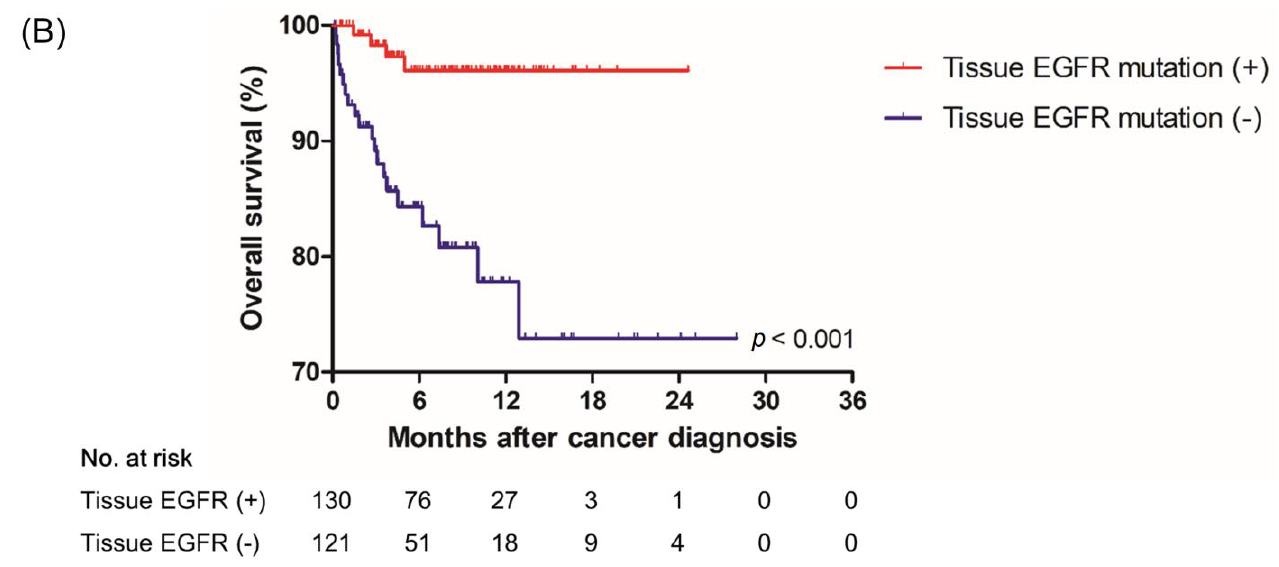
Figure 3. Survival plots of subjects with stage IV NSCLC according to ( A ) plasma and ( B ) tissue EGFR mutation status.